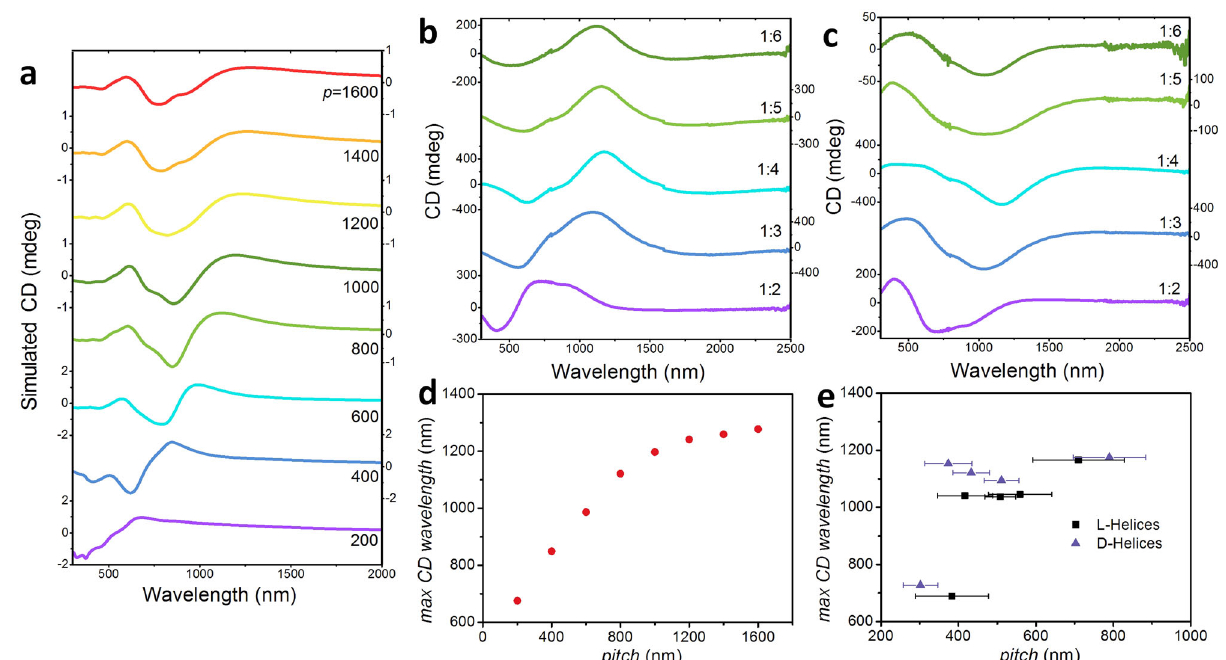
Fig. 4 Experimental and numerical results of CD spectra of assembled structures. a Numerical simulation of helical ribbons irradiated with circularly polarized electromagnetic waves of varying wavelength. The CD spectra are shown for helices with pitch ( p ) varied between 200 and 1600 nm. b , c Experimental measurement of normalized CD of [LH in ( b ) and RH in ( c )] helices of tetrahedral CdTe NPs at water/methanol ratios 1:2 – 1:6 where the yield of the helices is high. Helices of longer pitch, which occur at higher methanol, are studied using simulations ( a , d ). d , e Characteristic CD peak wavelength plotted as function of the helical pitch, from numerical simulations ( d ) and experiments ( e